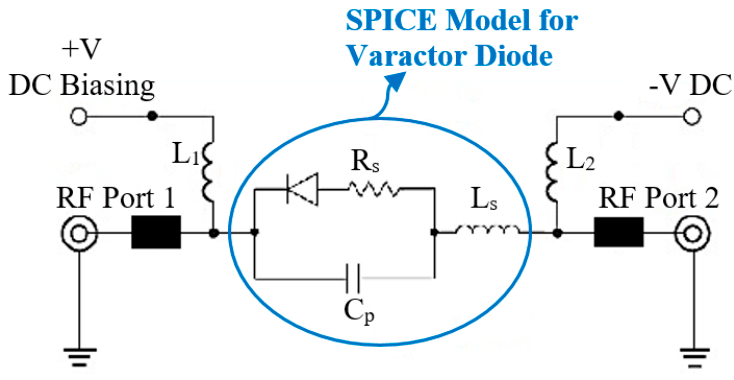
Figure 12. Biasing circuit with SPICE model of varactor switch [61].